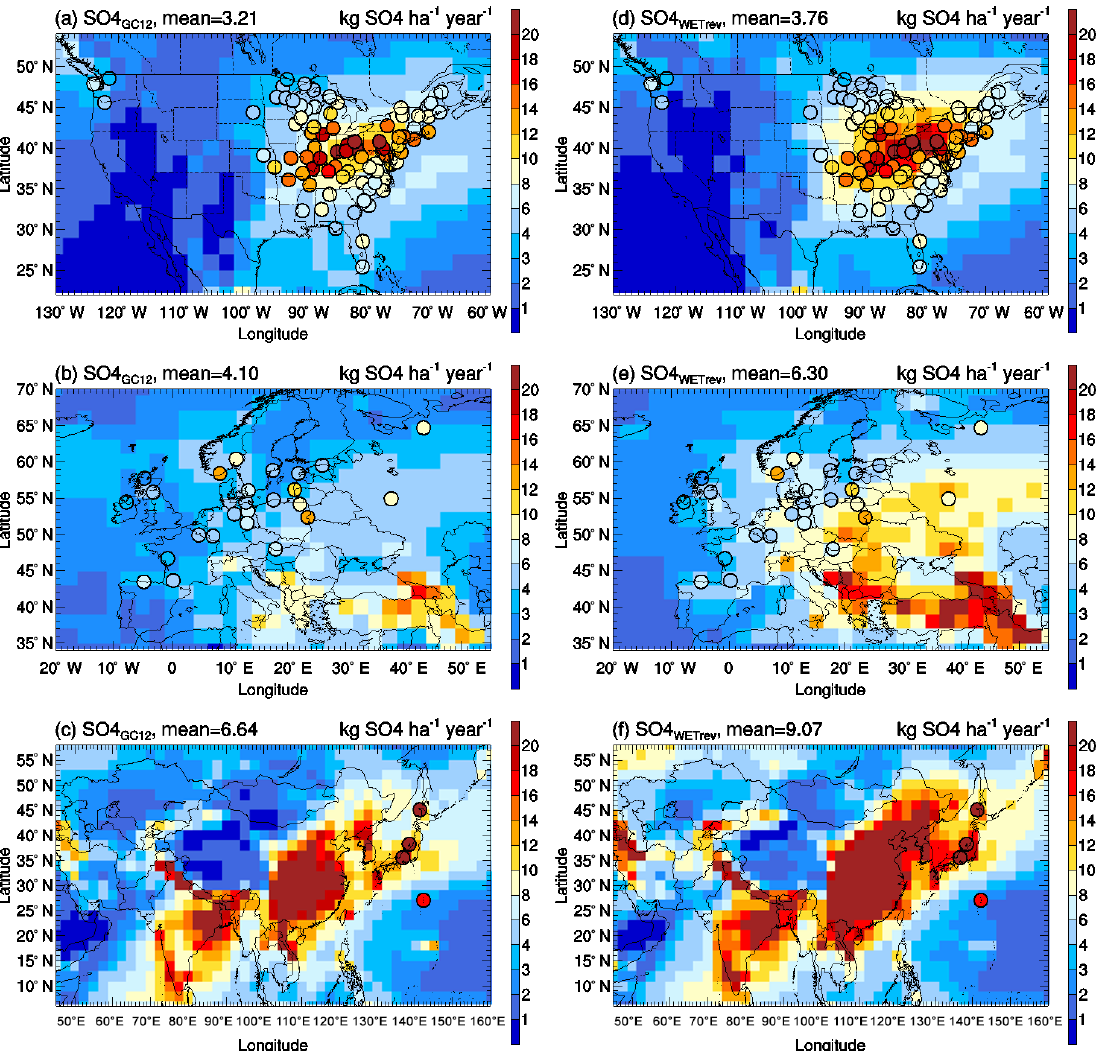
Figure 3. Horizontal distributions of SO 2 + SO 4 deposition over the US (a, d) , Europe (b, e) , and Asia (c, f) . Filled circles are annual mean wet deposition at NTN, EMEP, and EANET corrected following Paulot et al. (2014) to remove bias due to